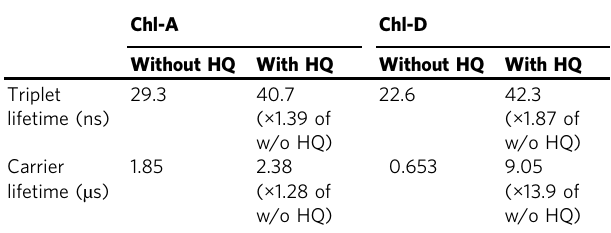
Table 1 Comparison of the triplet and carrier lifetimes in the Chl-A and Chl-D fi lms with and without